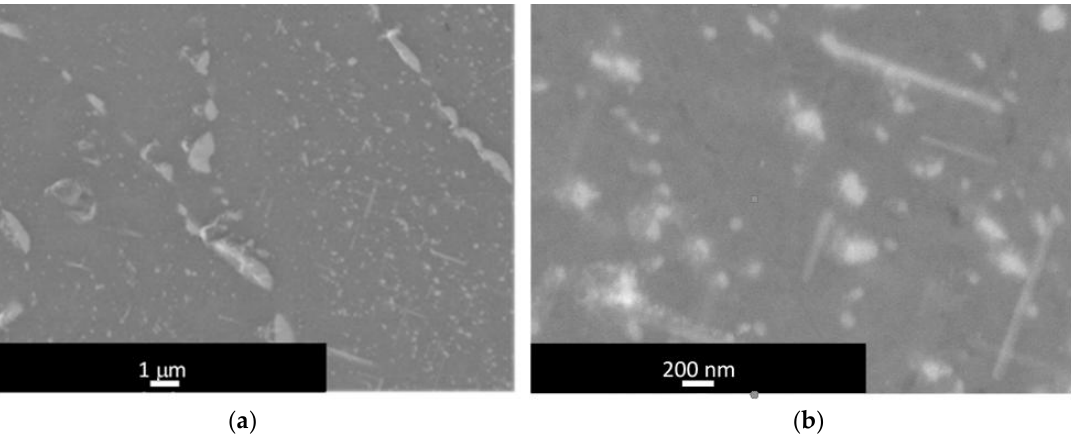
Figure 3. Microstructure of the sample tested under 25 MPa at 315 ◦ C up to rupture. The distribution of precipitates was quite inhomogeneous in the various grains. The grain on the right in ( a ), in particular, was one of those with a higher volume fraction of particles. Semi-continuous chains of coarse particles precipitated during creep highlight grain boundaries. In ( b ), elongated particles can be easily observed, alongside small circular precipitates (most easily rods observed in a transversal section) and slightly coarser equiaxed particles.